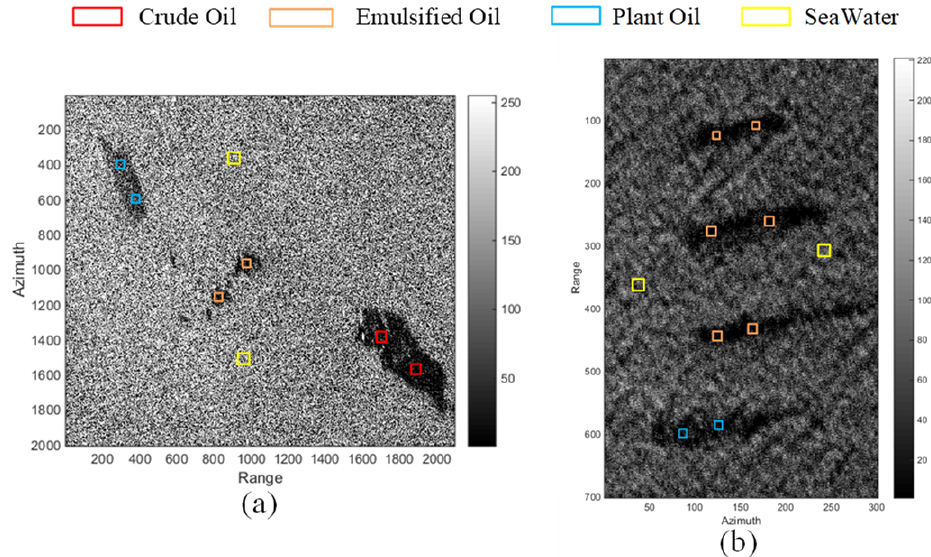
Figure 4. Span image of oil spill at sea: ( a ) Case 3; ( b ) Case 4.